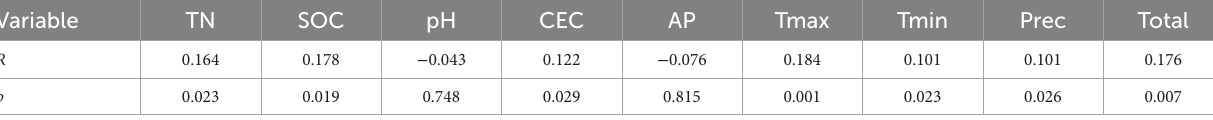
TABLE 4 Correlations between fungal community structure and environmental variables assessed by Mantel tests.